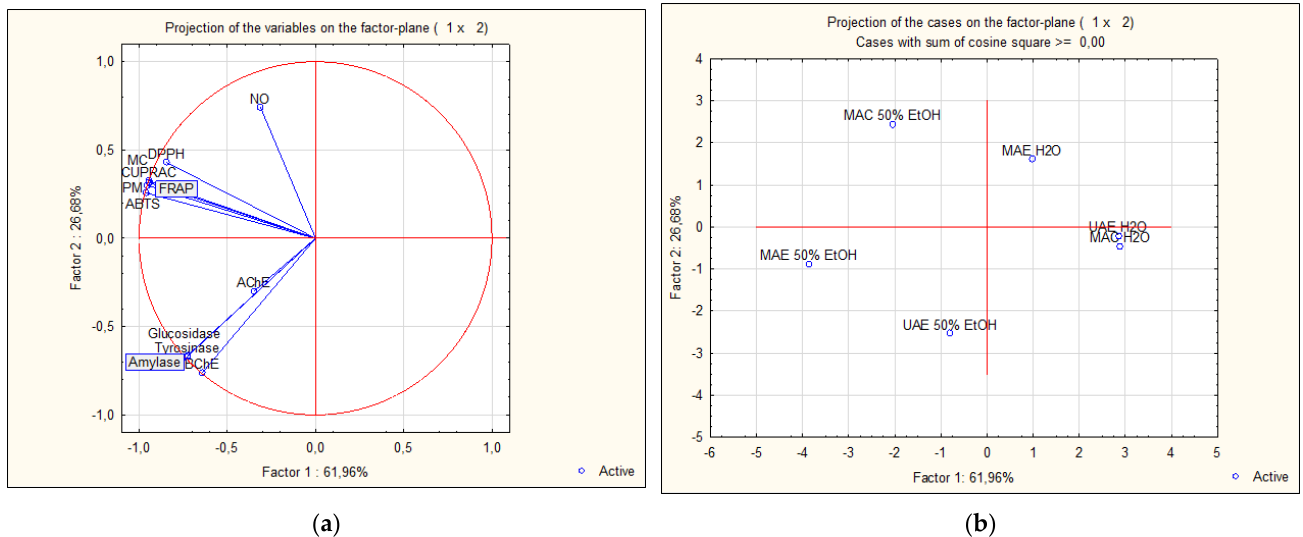
Figure 3. Principal component analysis of antioxidant and enzyme inhibitor activity in fresh fruits of elderberry extracts. ( a ) Distribution of variables on loadings plot; ( b ) distribution of elderberry extracts on scores plot.